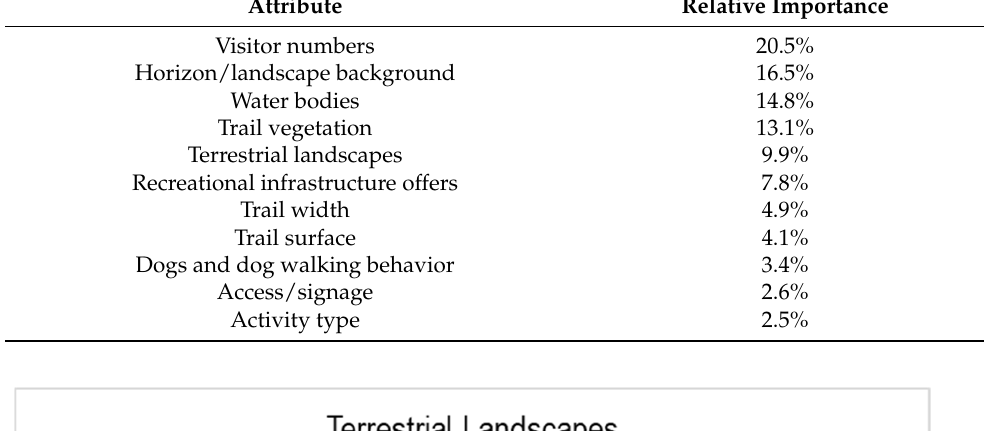
Table 2. Relative importance of the attributes for riverscape preferences based on the conditional logit model ( n = 520).